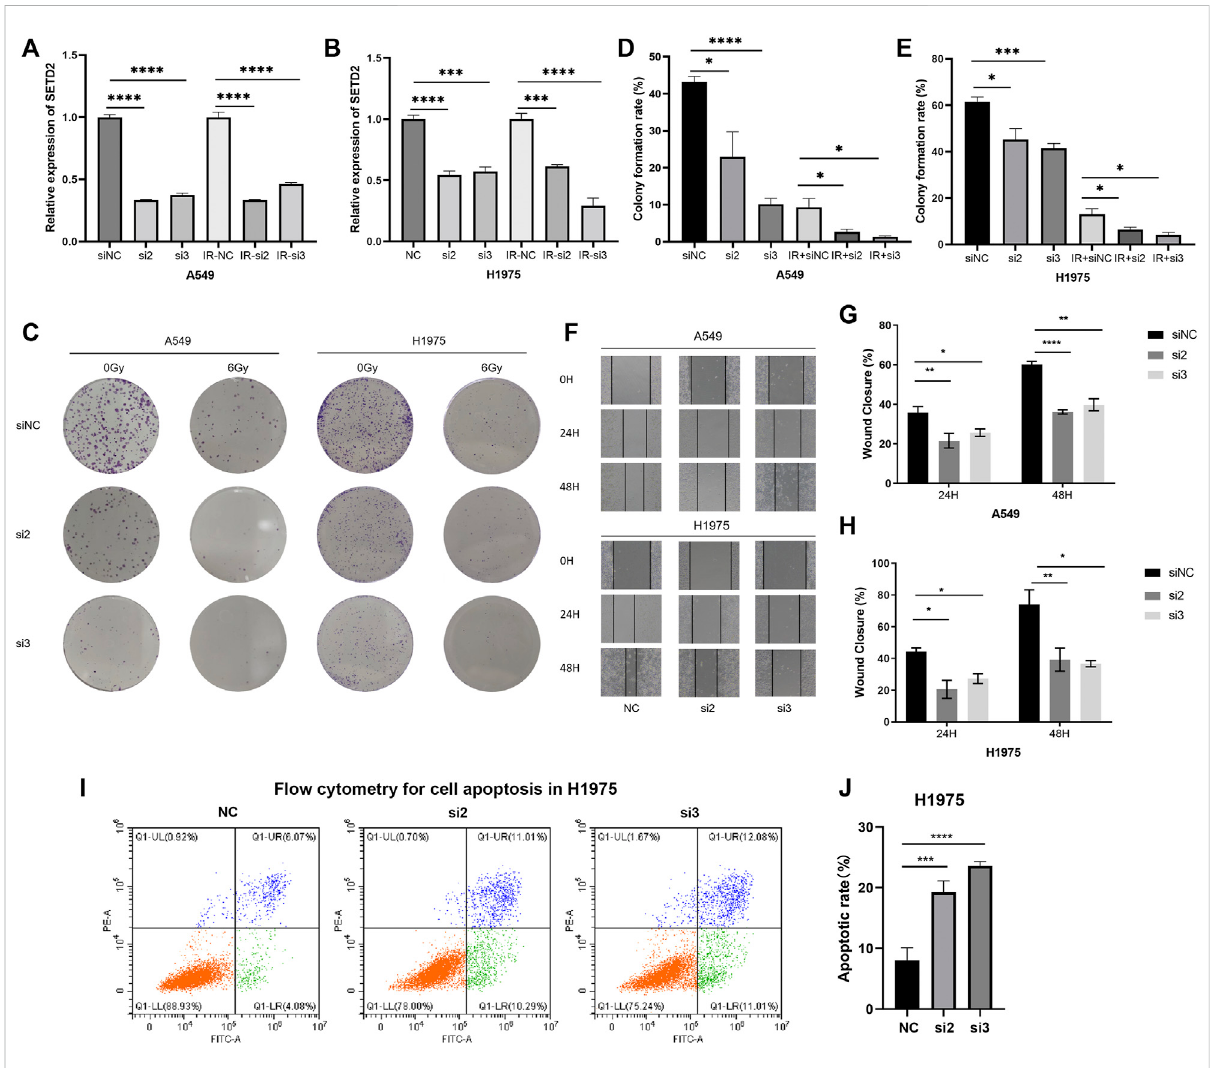
FIGURE 6 Flow cytometry, wound healing assays and clone formation experiments treated with siSETD2 or radiation. (A) The qRT-PCR of SETD2 in A549 cells. (B) The qRT-PCR of SETD2 in H1975 cells. (C) The six well plate image of clone formation experiment. (D) Clone formation rate of A549 cells. (E) Clone formation rate of H1975 cells. (F) Wound healing assay image. (G) Wound closure rate of A549 cells. (H) Wound closure rate of H1975 cells. (I) Flow cytometry for cell apoptosis in H1975. (J) Quantitative results of